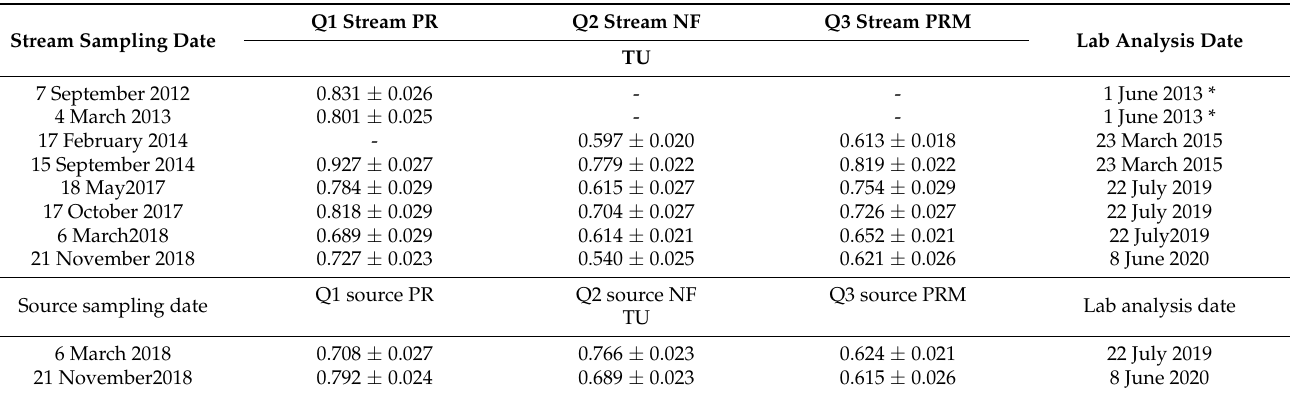
Table 7. Tritium concentrations (TU) at sampling dates in three experimental catchments at Quivolgo and lab analysis dates.